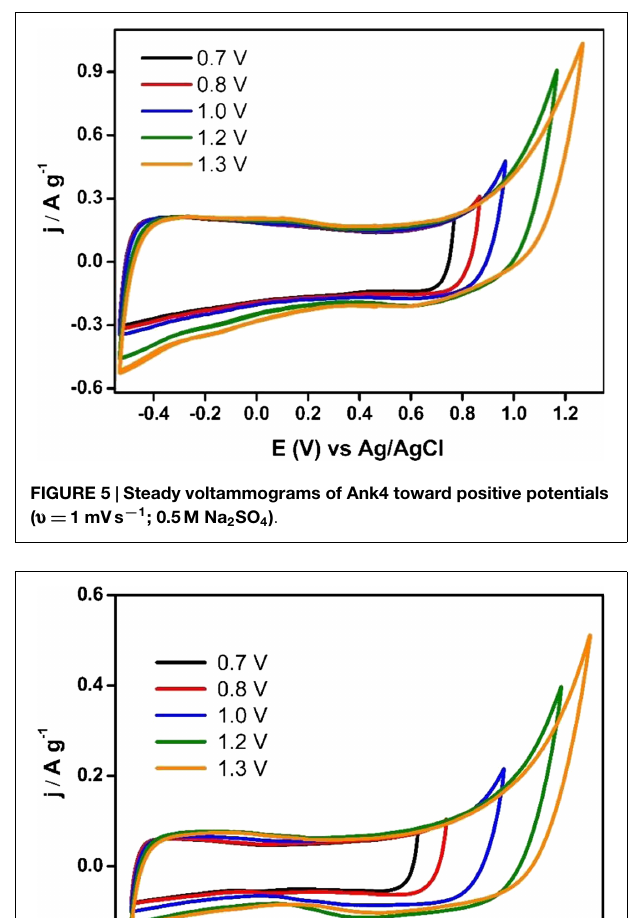
voltammograms similar to those showed in Ank_H 2 from 0.2 V